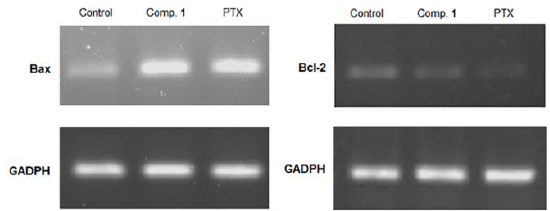
Figure 7. Effect of Compound 1 (21.3 µM) for 72 h, on mRNA expression levels of Bcl-2 and Bax in Hep3B cell line. Paclitaxel (PTX) (20 nM) was used as positive control. GAPDH was used as an internal control.